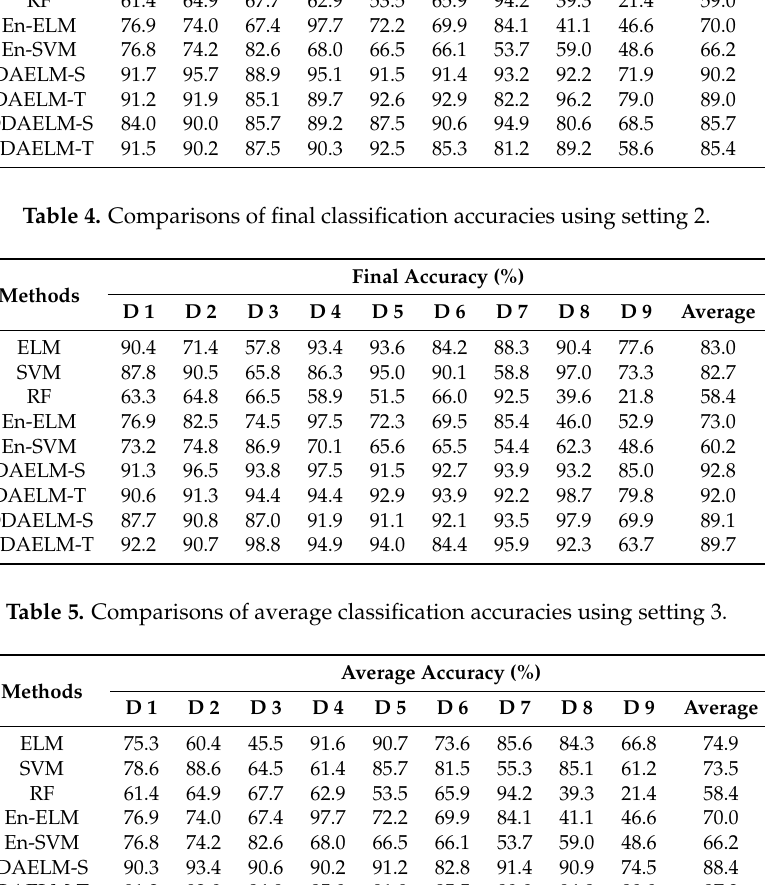
Table 3. Comparisons of average classification accuracies using setting 2.